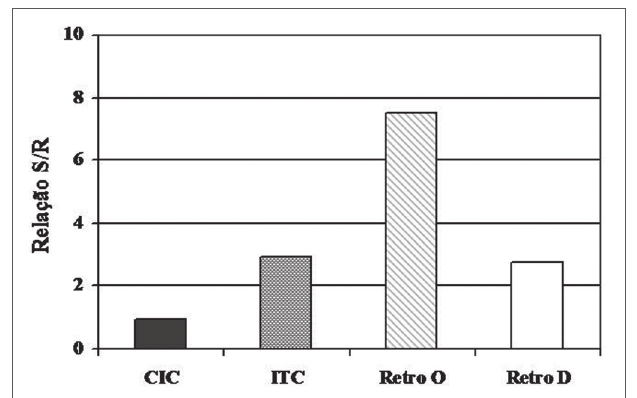
Gráfico 2. Valores médios da relação S/R onde foram reconhecidos 50% das sentenças para os diferentes grupos avaliados (n=34).